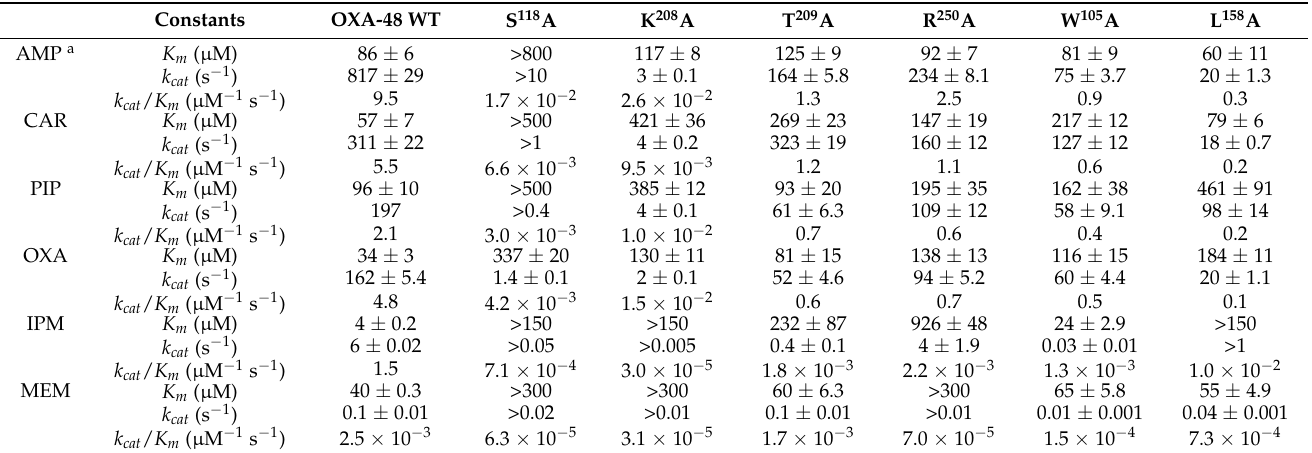
Table 2. Kinetic constants of OXA-48 variants towards seven β -lactams.